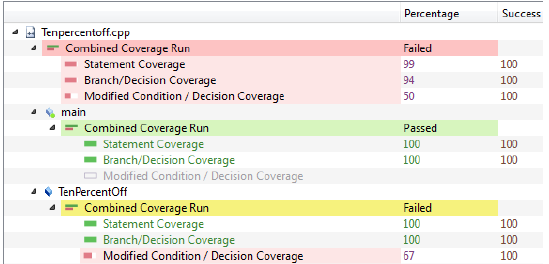
Fig. 5. Test Coverage